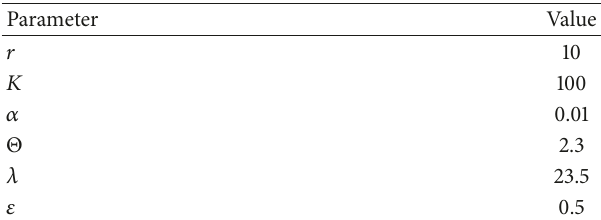
Table 1: Values for the parameters used in